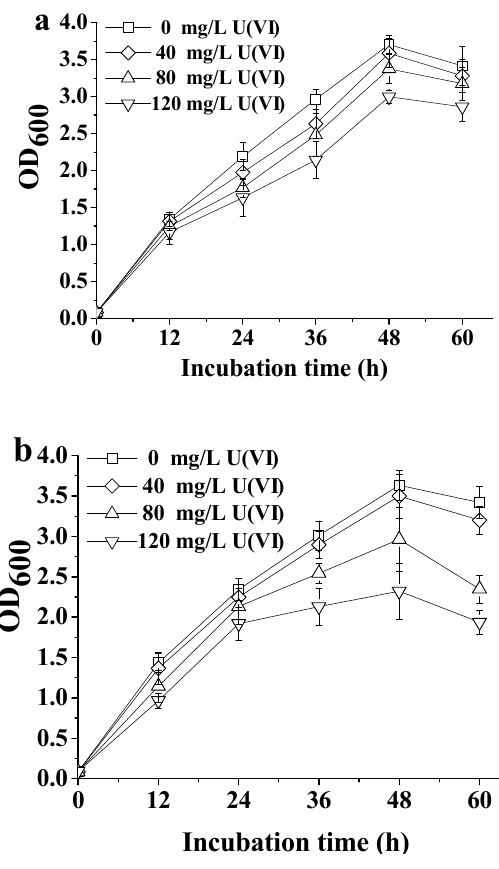
Figure 1. Growth dynamics of the ATCC9372 strain ( a ) and the Ua strain ( b ) in the U(VI) having growth media with different concentrations of uranium. All experiments were performed in triplicate. Average results of tree experiments were shown; bars represent standard deviations.